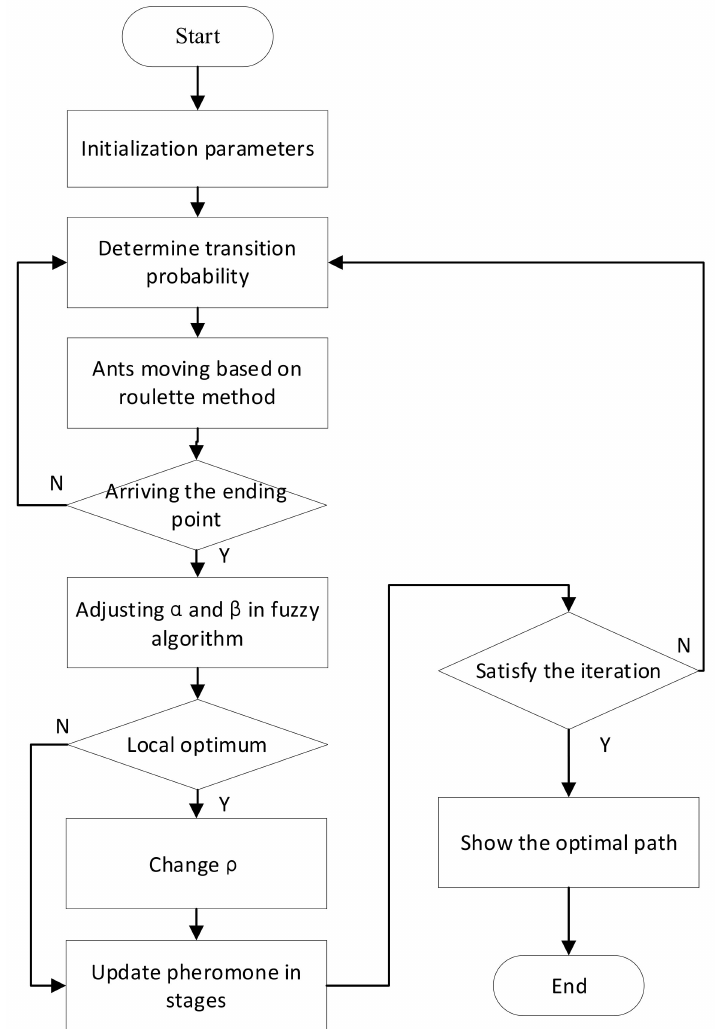
Figure 7. Flow chart of the improved ACO.